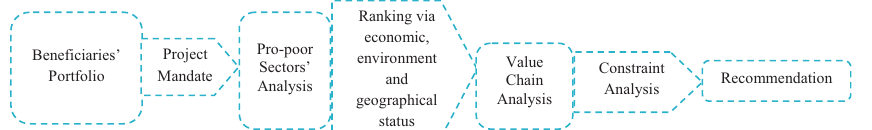
Figure 2. Present study